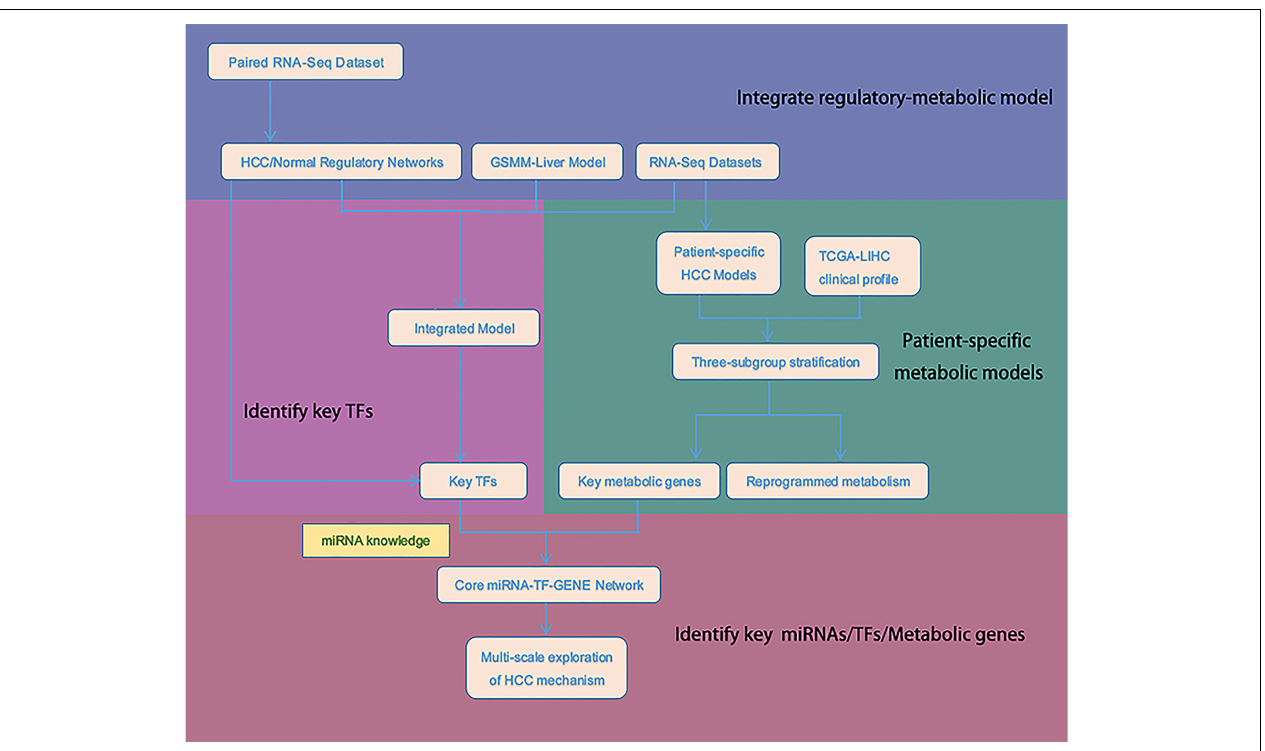
FIGURE 1 | The schema of the integrated model for stratification and key targets